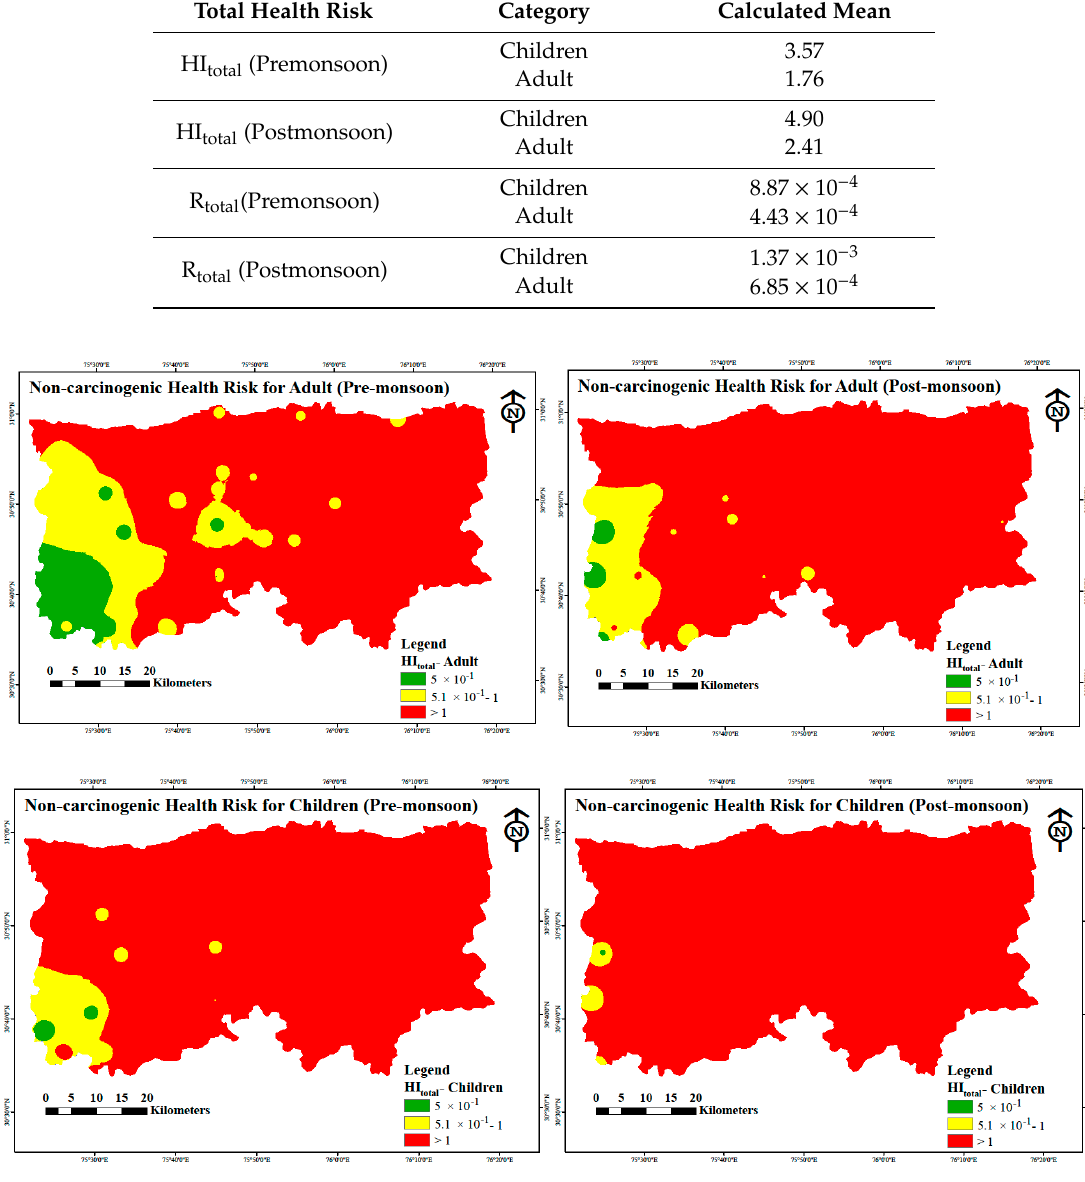
Figure 5. HI total for adults and children during pre- and postmonsoon periods.